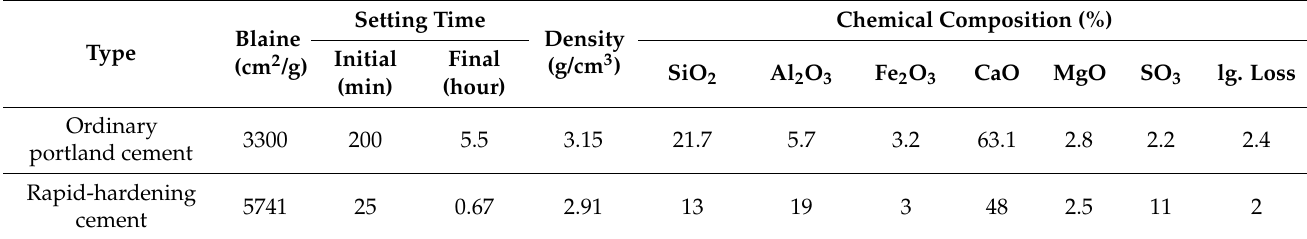
Table 1. Physical properties and chemical composition of ordinary Portland cement